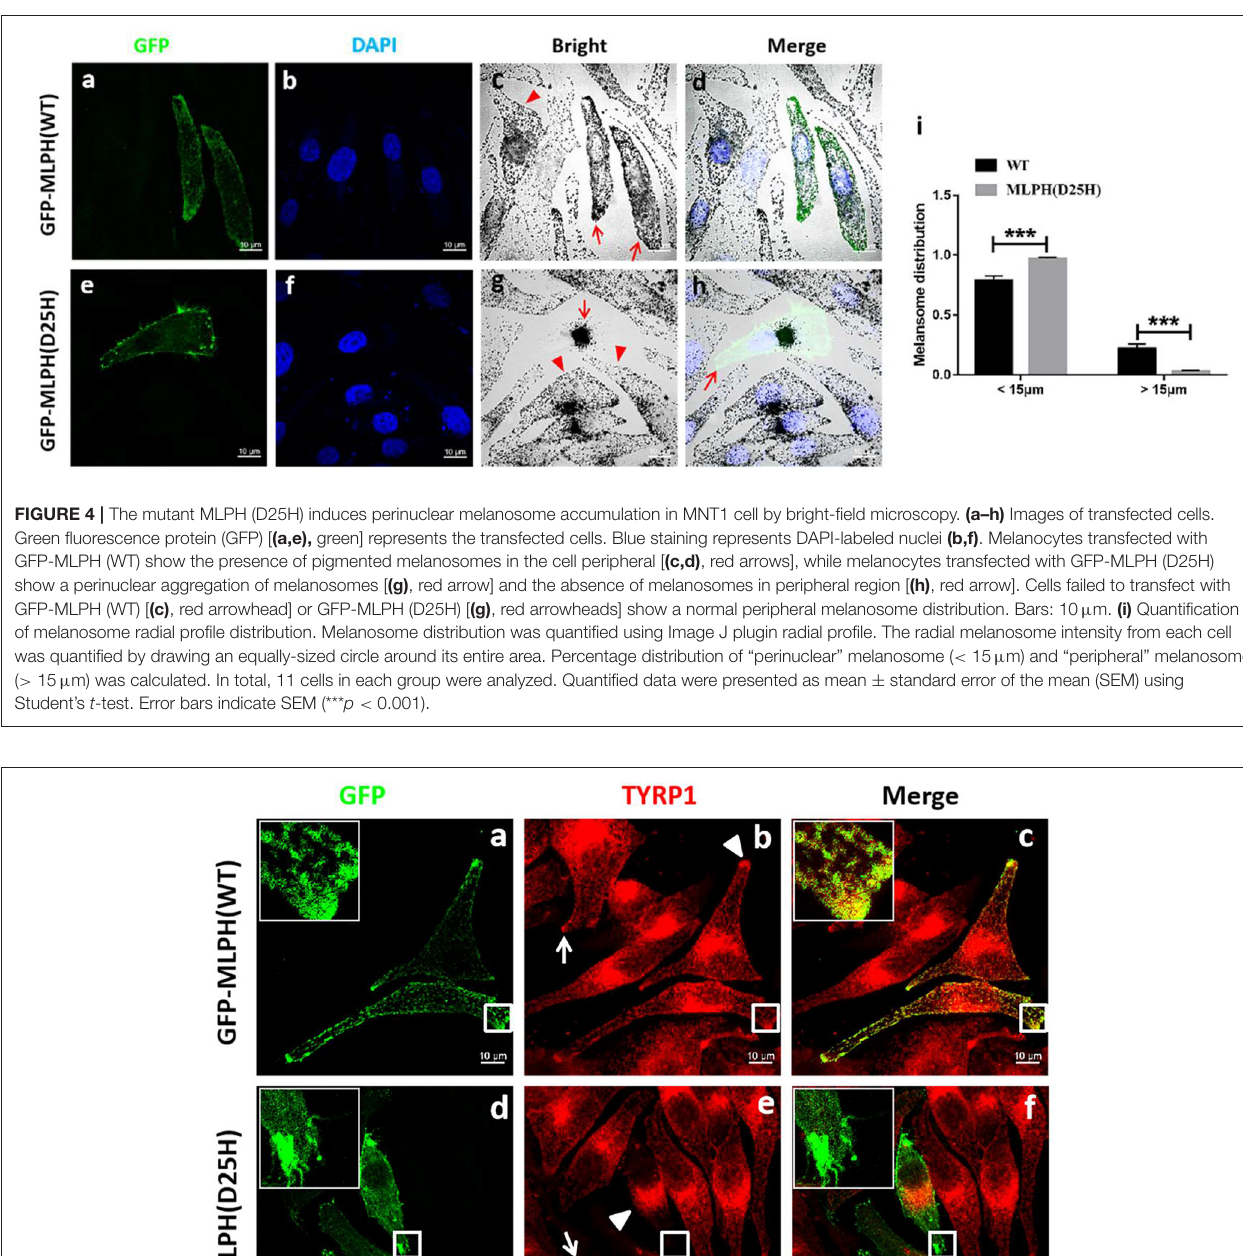
were used to examine the distribution of melanosomes. transfected with green fluorescence protein (GFP)-MLPH (WT) ( Figure 4c , red arrows) and un-transfected cells from the same field of view ( Figure 4c , red arrowhead) had